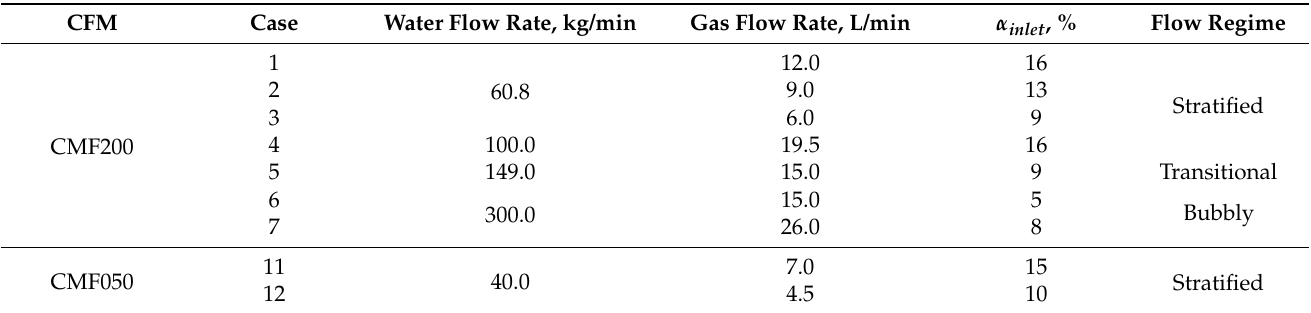
Table 1. Experimentally investigated multiphase flow